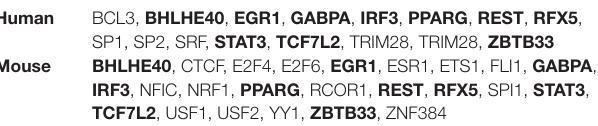
TABLE 9 | TFs enriched in “ENCODE and ChEA Consensus TFs from ChIP-X” by Enrichr for human and mouse. Bold TFs are common. Human